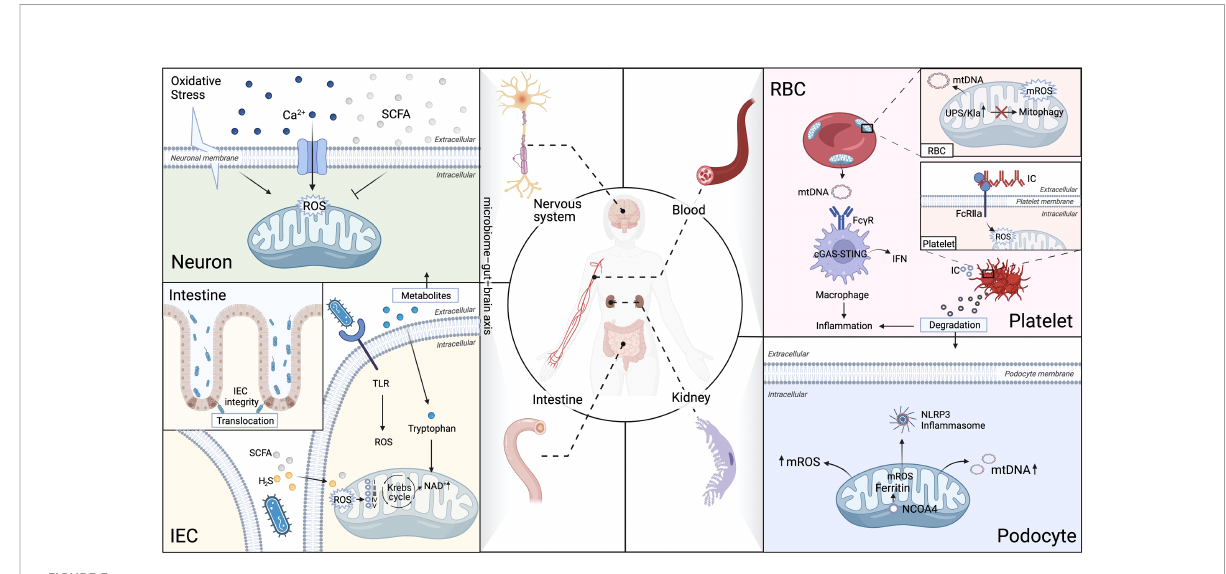
FIGURE 3 Aberrant mitophagy and redox disturbance cause multiple organs damage in SLE. SLE is a heterogeneous systemic autoimmune disease, affected multiple organs, such as kidney, nerves, gut and hematologic (non-immune cells). (A) Brain-Gut axis is novel therapeutic strategy on modulation of mitochondrial dyshomeostasis by neutralizing excessive ROS in microglial cells in neuropsychiatric SLE (NPSLE). (B) Extracellular mitochondria (speci fi cally platelets mitochondria and erythrocytes) serve as an immunogenic DNA, activated the cGAS – STING pathway, consequently trigger IFN- a production through binding to Fc g RIIA in SLE. (C) The microbiota metabolites can directly interfere with the mitochondrial redox status in the host cells. Microbiota metabolites, such as hydrogen sul fi de (H 2 S), short-chain fatty acids (SCFAs), and tryptophan, play an essential role in regulation of intestinal epithelial cells (IEC) integrity in SLE. (D) Impaired mitochondrial degradation in glomerular and tubular cells causes proteinuria and renal failure in LN. Iron loss-induced mitophagy is associated with the mitochondrial ferritin by nuclear receptor coactivator 4(NCOA4). Iron-induced injury of glomerular and tubular cells has been attributed to excessive mROS production, which contributes to drive NLRP3 in fl ammasome activation in SLE podocytes. Ubiquitin-proteasome system (UPS), Five respiratory complexes (complexes I – V), tricarboxylic acid (TCA)